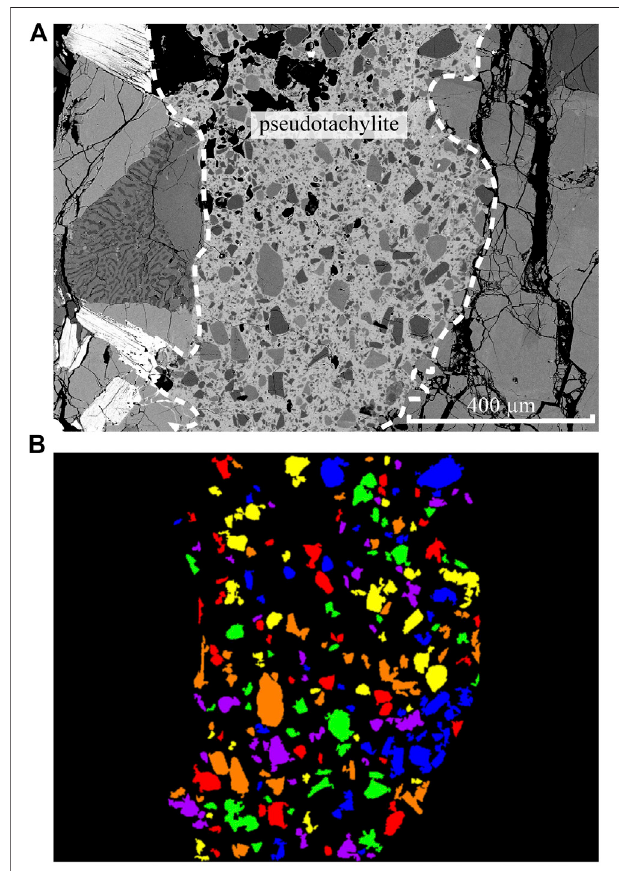
FIGURE 2 | Illustration of the semi-automatic particle size and shape method based on the Matlab code “ Gray Scale Image Analyses ” (Bjørk et al., 2009). (A) Original BSE image. (B) Output image after code application. Each grainisdifferentiatedfromthebackgroundmatrixbasedonitsgrayscale and assigned a random color to facilitate later segmentation by automated analysis using